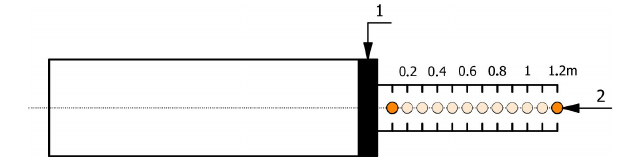
Figure 7: Test station 1) waveguide output, 2) fire source